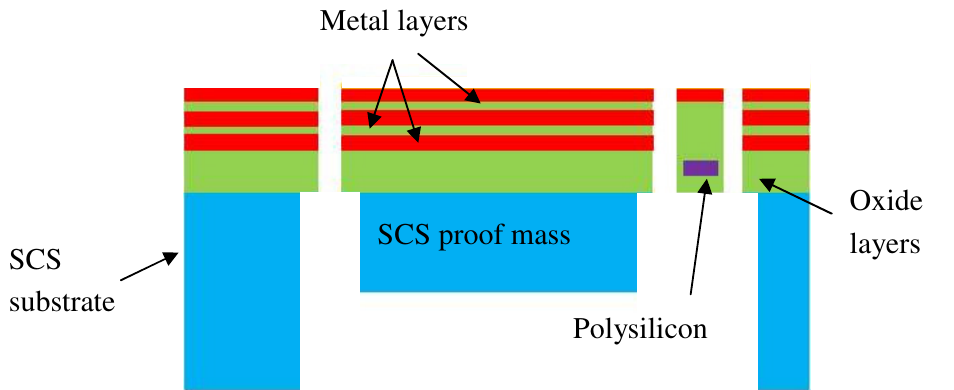
Figure 2. Schematic cross-section of a released sensor showing the CMOS thin films and their relative